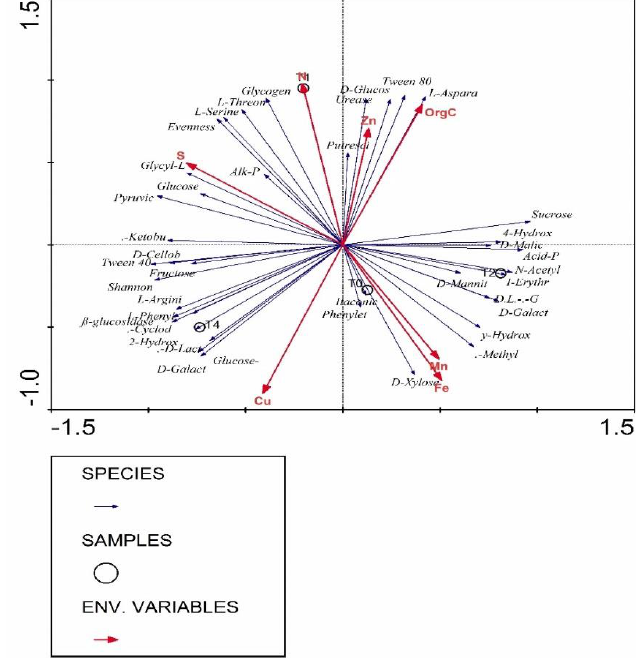
Figure 5. Correlations of soil amino sugar data, rhizobium inoculation treatments (T0 = control (no rhizobium), T1 = 100, T2 = 200 and T4 = 400 grams of rhizobium per 100 kg of seeds) and soil environmental variables including organic C, nitrogen (N), Zinc (Zn), Sulphur (S), Copper (Cu), Iron (Fe) and Manganese (Mn) determined by redundancy analysis